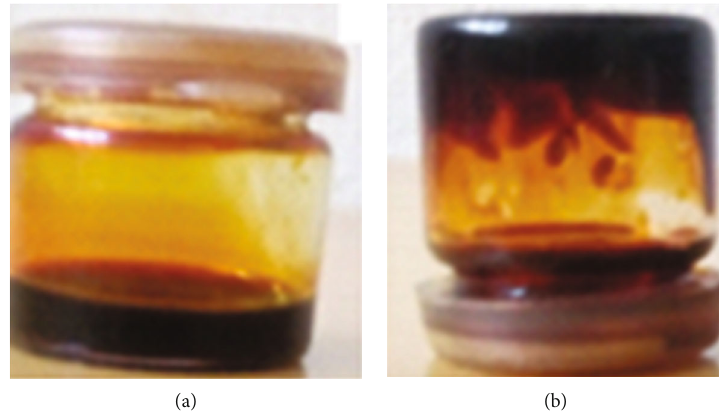
Figure 4: (a) Upright and (b) inverted pictures of a vial containing prepared